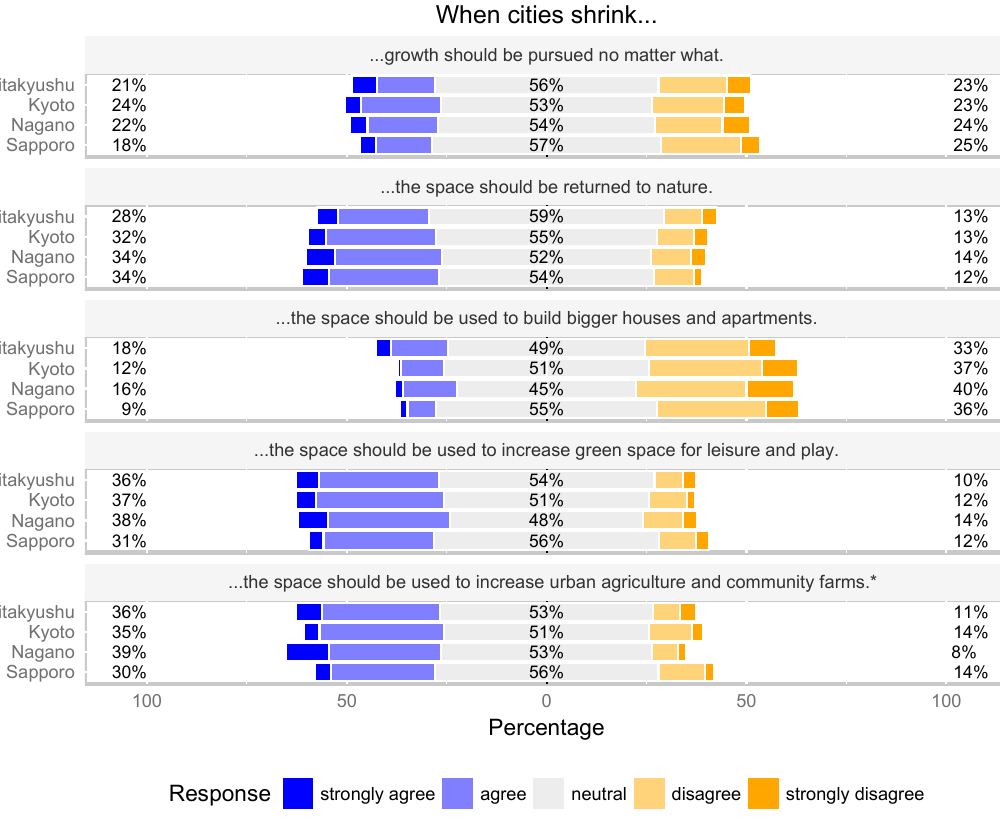
Figure 4. Respondents’ opinion on how to proceed when cities are shrinking.